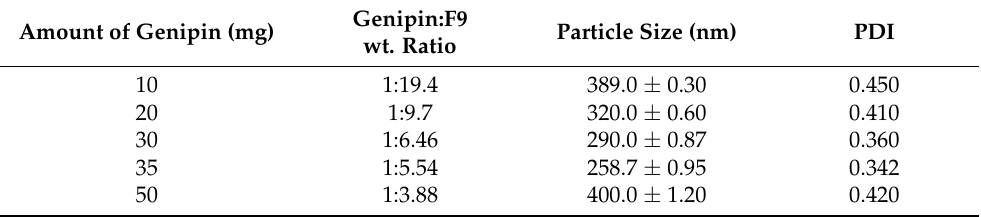
Table 2. Effect of genipin amounts on zeta potential, PDI and particle size of nanohybrids F10 ( n = 3). Amount of Genipin (mg)